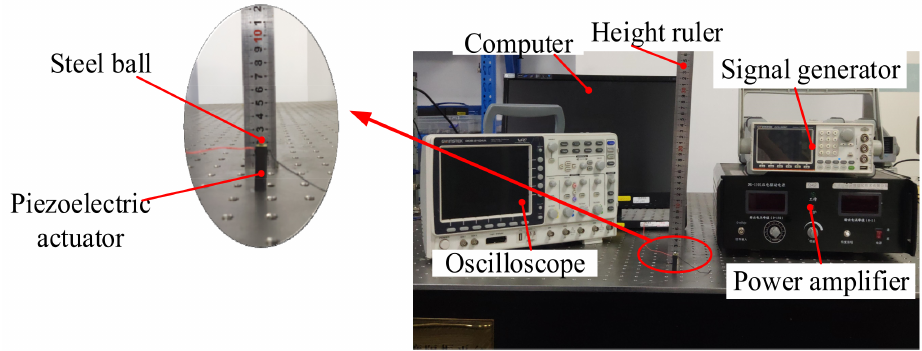
Figure 6. The established experimental apparatus of the piezoelectric actuator bouncing the steel ball.